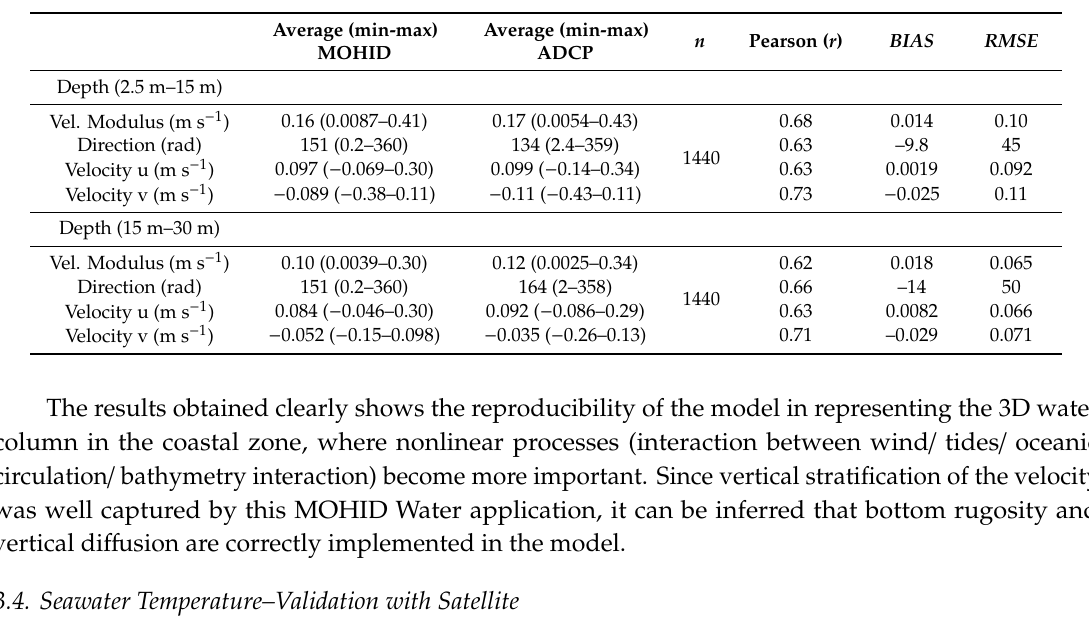
Figure 7. Profiles comparison between MOHID Water results ( top ) and ADCP data ( bottom ) for the velocity components u and v in function of depth. Data obtained off Cascais between 2 and 17 July 2009. Grey lines represent velocity at each instant of time measured or predicted, and blue and green lines represent the average trend. Table 4. Current velocity and direction. Data summary and results of statistics used to assess the level of agreement between measured data and modelling results. n —number of observations; r —correlation coe ffi cient; BIAS —Average bias; RMSE —Root mean square